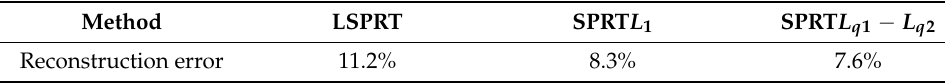
Table 1. Reconstruction error